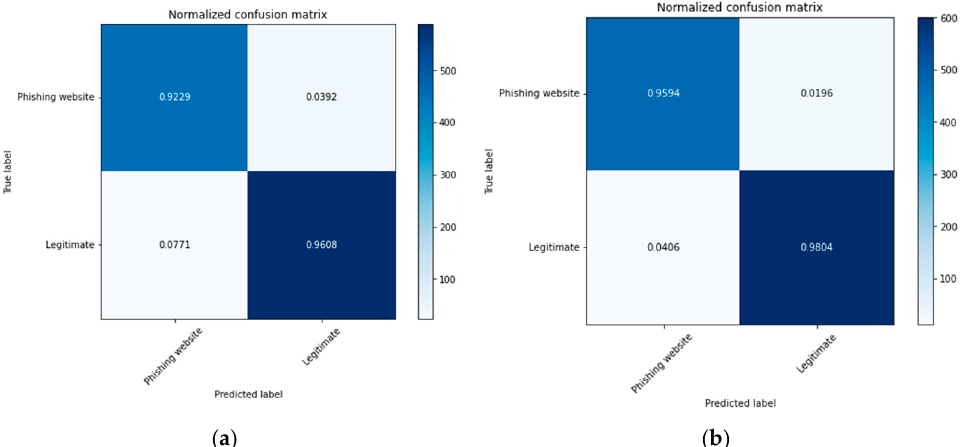
Figure 6. A normalized confusion matrix of XGBoost for phishing website and legitimate website classification: ( a ) with default parameters; ( b ) with optimized parameters for Dataset 1.